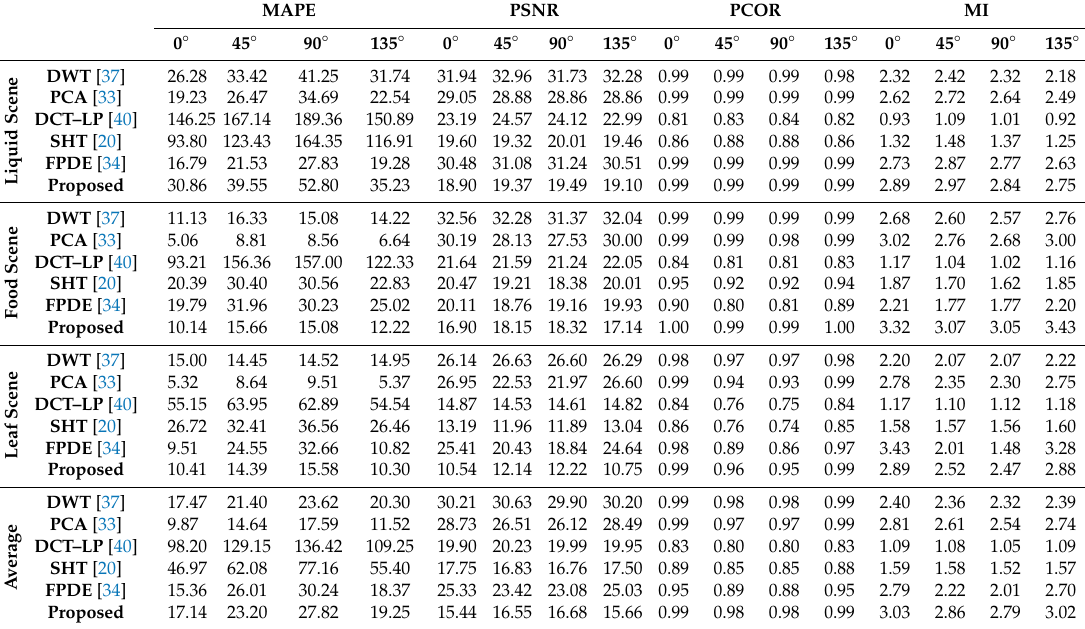
Table 1. Mean Absolute Percentage Error and Peak Signal-to-Noise Ratio error metrics (MAPE, PSNR) and Pearson Correlation Coe ffi cient and Mutual Information correlation metrics (PCOR, MI) of di ff erent fusion methods.